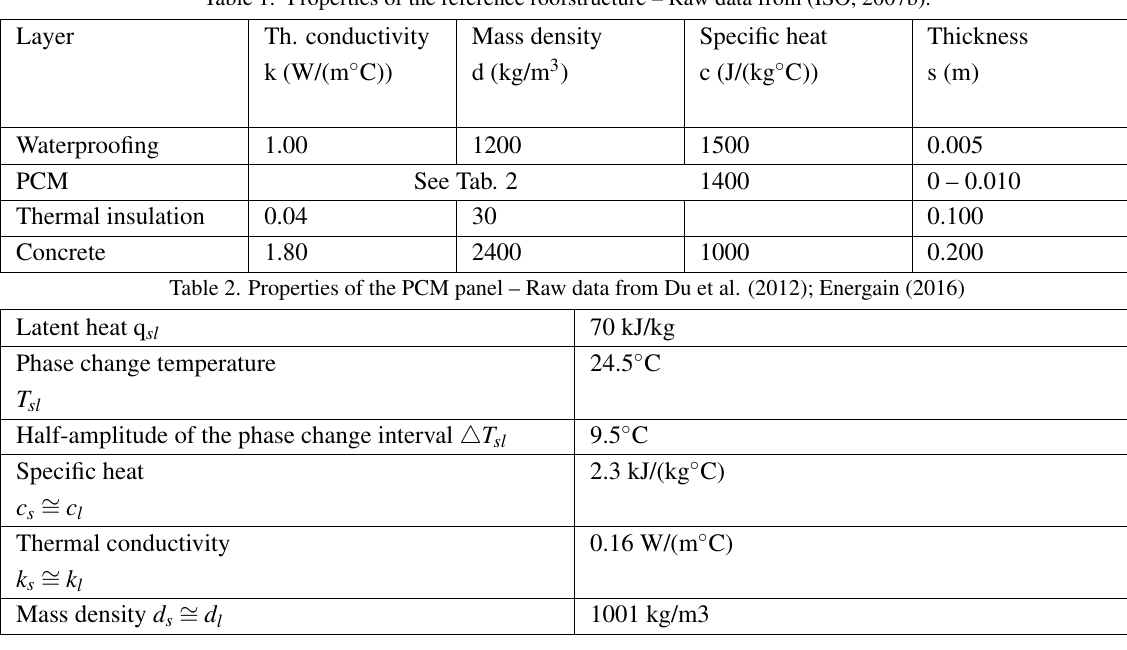
Table 1. Properties of the reference roofstructure – Raw data from (ISO, 2007b).